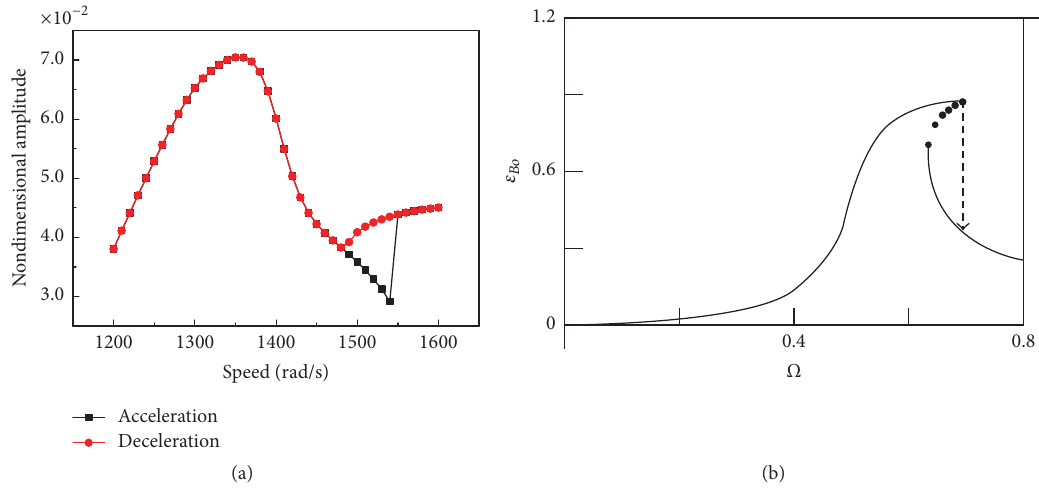
Figure 6: Steady state responses of rotor in this paper (a) in this paper (b) in